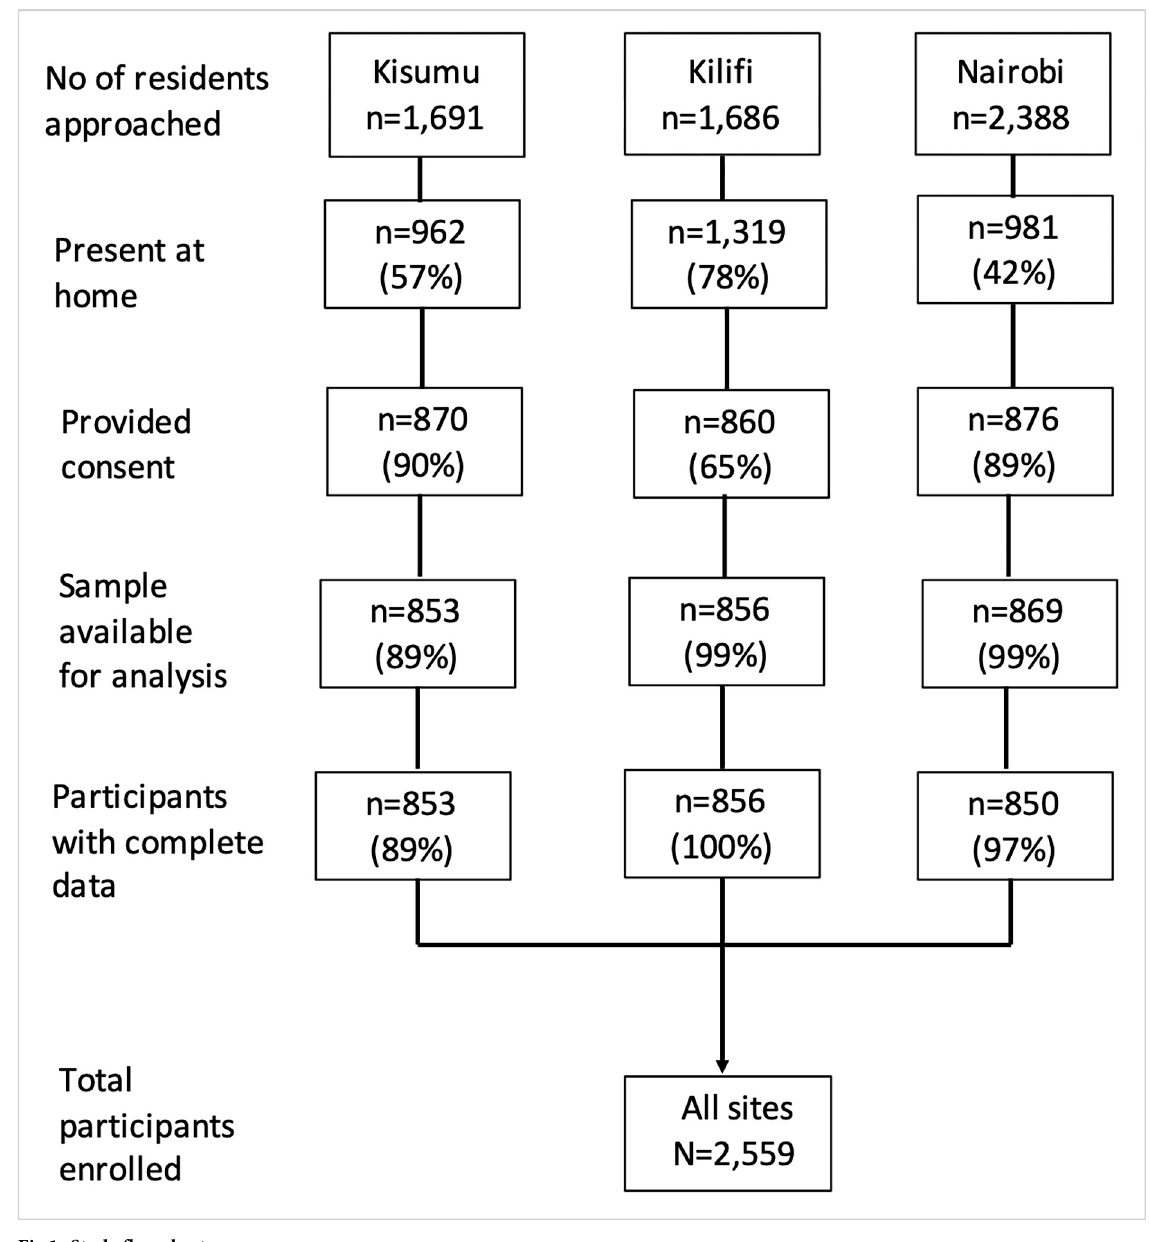
Fig 1. Study flow